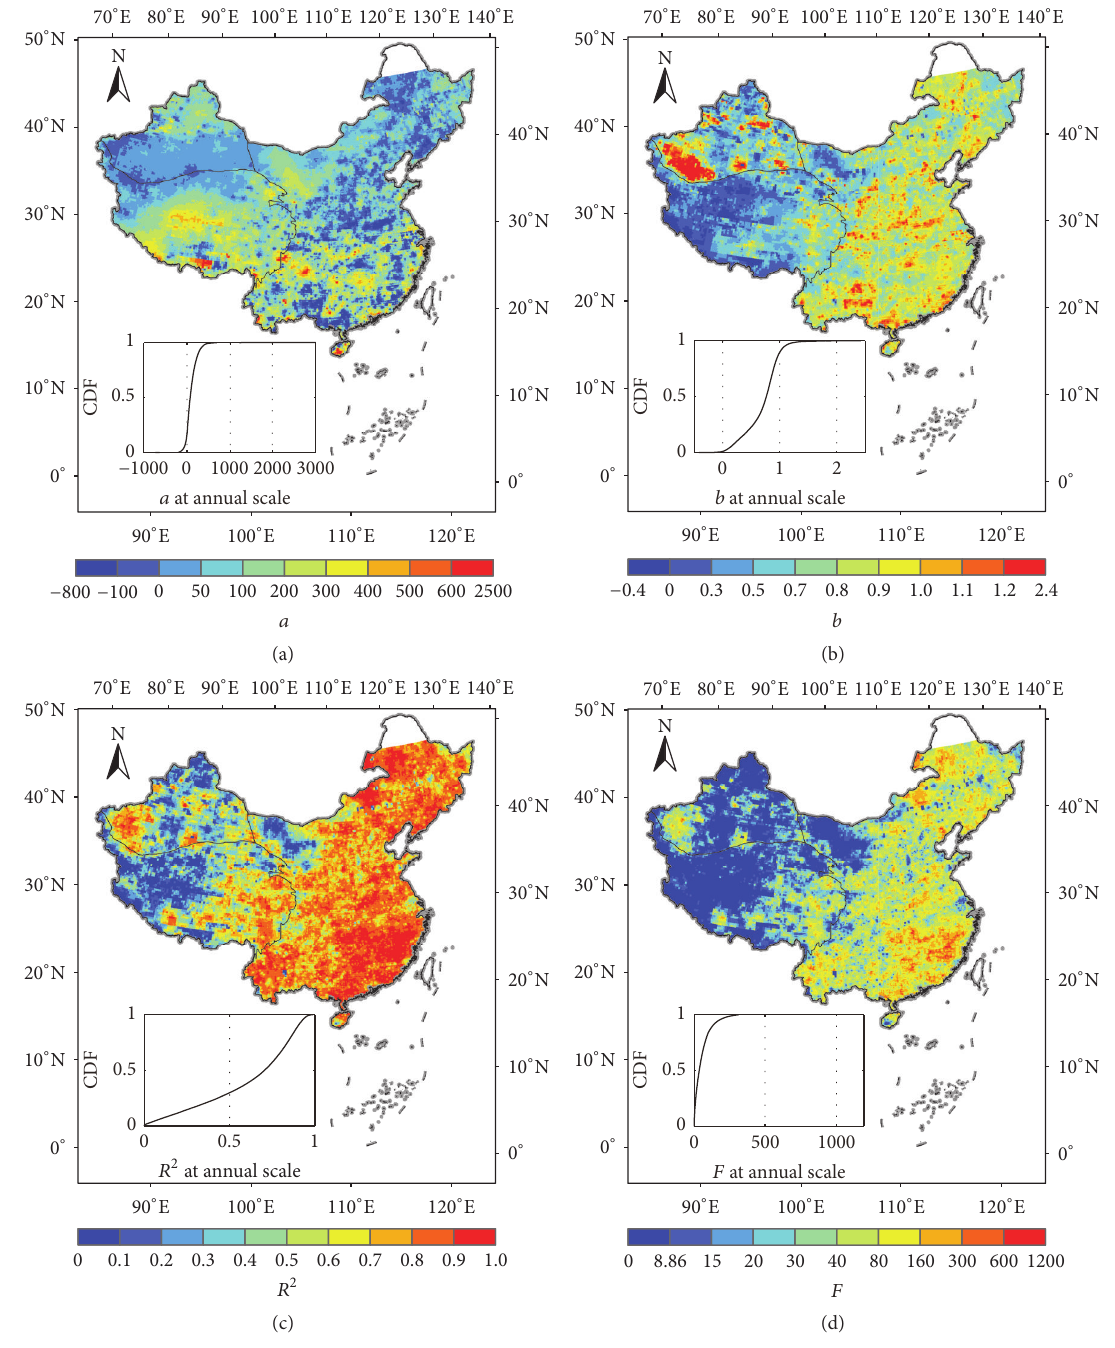
Figure 5: Annual linear regression model results over China: (a) offset parameter 𝑎 , (b) scale parameter 𝑏 , (c) 𝑅 2 , and (d) 𝐹